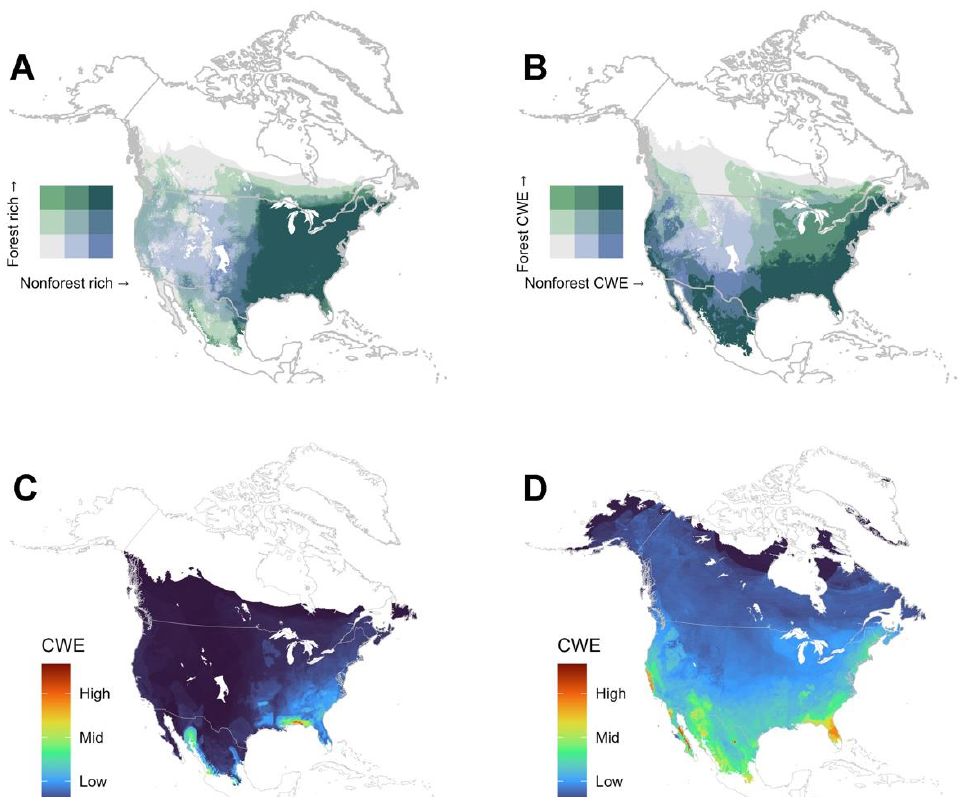
Figure 2. Species richness and corrected weighted endemism for terrestrial habitats used by Odonate species in the Nearctic realm. ( A ) Bivariate plot showing distribution of richness for forest-dependent and non-forest-dependent species; ( B ) bivariate plot showing distribution of corrected weighted endemism (CWE) for forest-dependent and non-forest-dependent species; ( C ) corrected weighted endemism (CWE) for forest-dependent species; ( D ) corrected weighted endemism (CWE) for non-forest-dependent species.